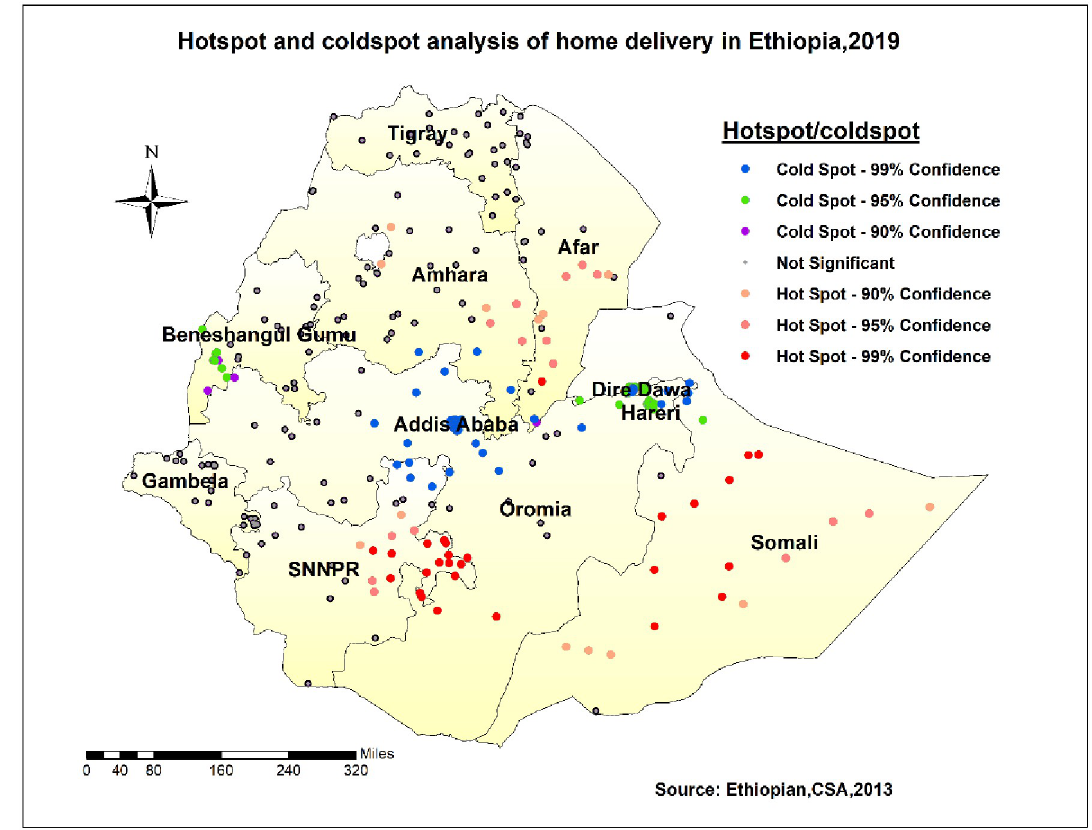
Fig 4. Hotspot/Cold spot analysis of home delivery in Ethiopia,